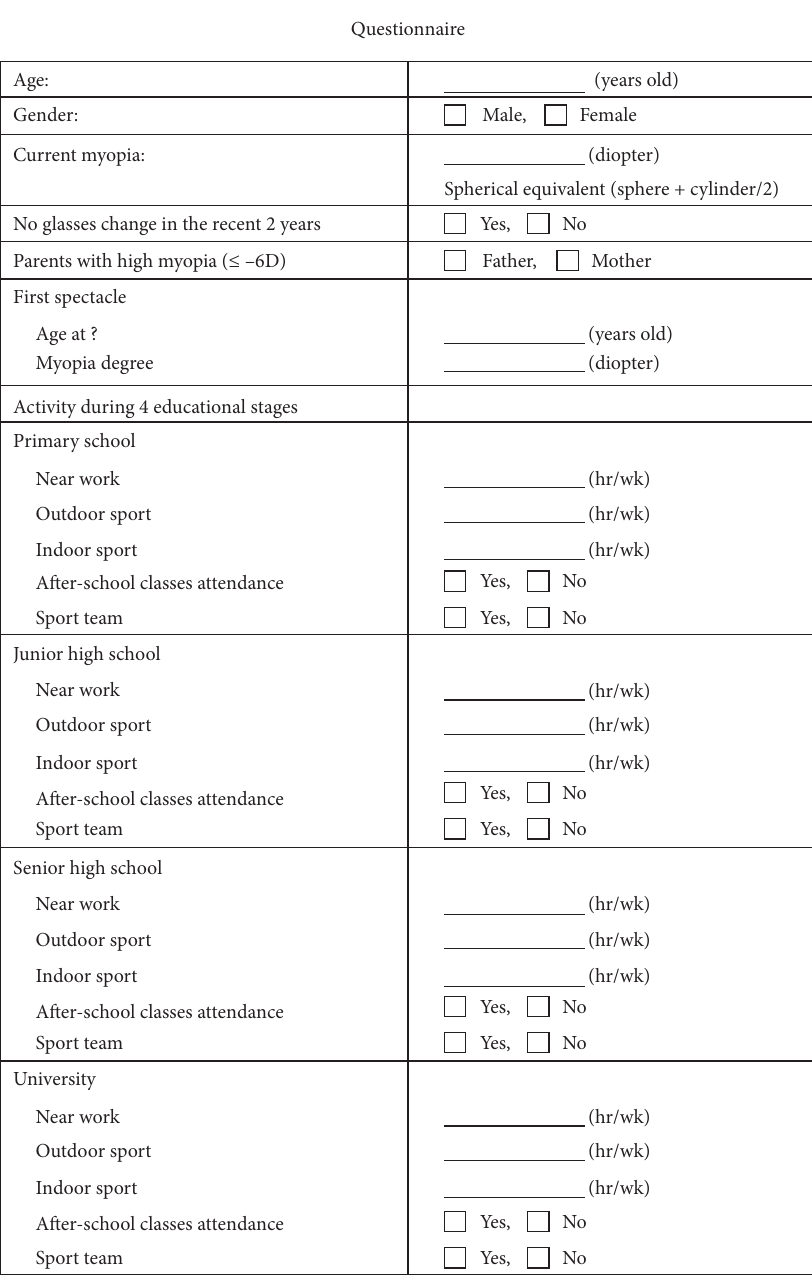
Figure 1 : A self-completed questionnaire was used to collect sex, age, current myopia degree, high myopia in parents, age at first spectacle use, refractive power of first spectacles, and life habits at four different educational